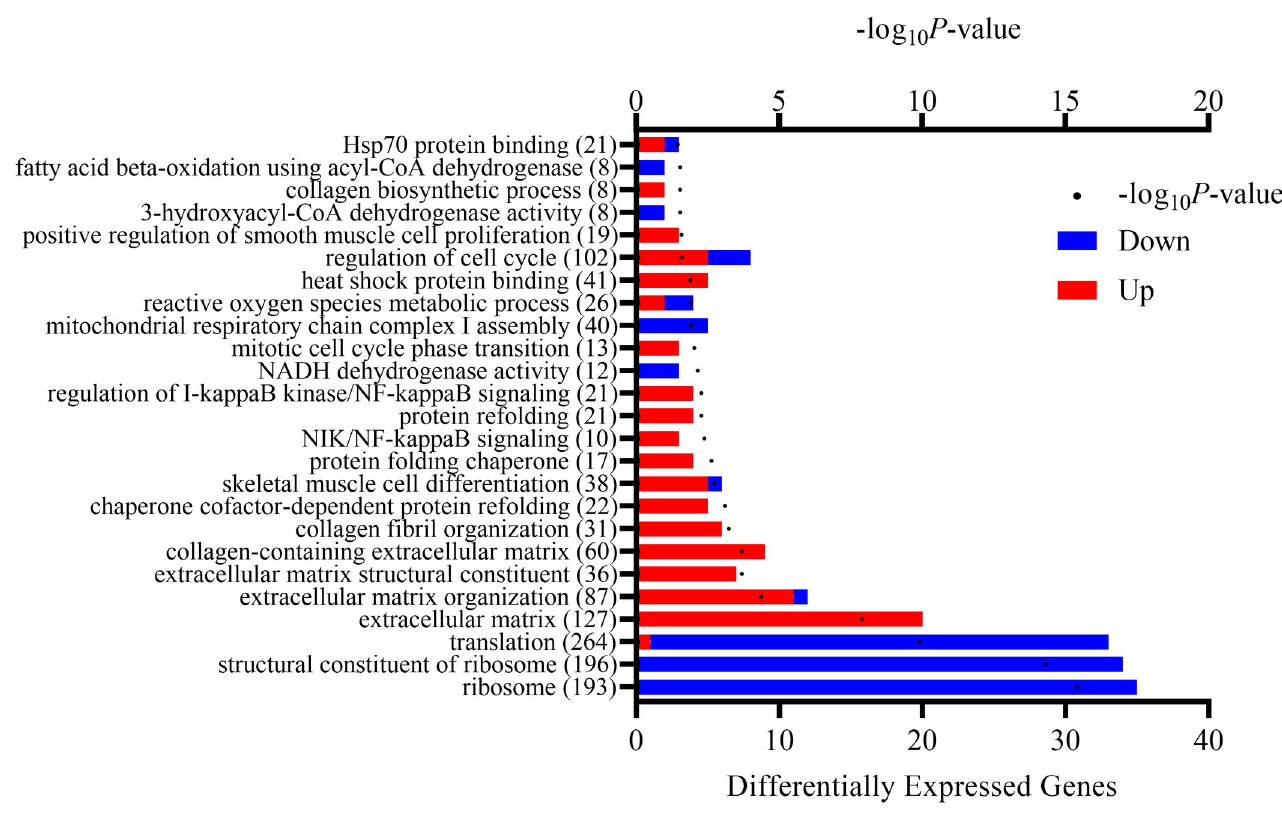
Fig 5. Significantly enriched gene ontology (GO) terms in the Longissimus dorsi muscle of early-weaned Bos indicus -influenced calves for the main effect of time (pre- vs. post-vaccination). The number of differentially expressed genes ( P � 0.0001) is reported along the bottom x-axis and depicted by bars while the -log 10 P -value is reported along the top x-axis is indicated by dots. Blue bars indicate downregulated genes while red bars indicate upregulated genes. The number in parentheses is the total number of genes associated with each functional term.